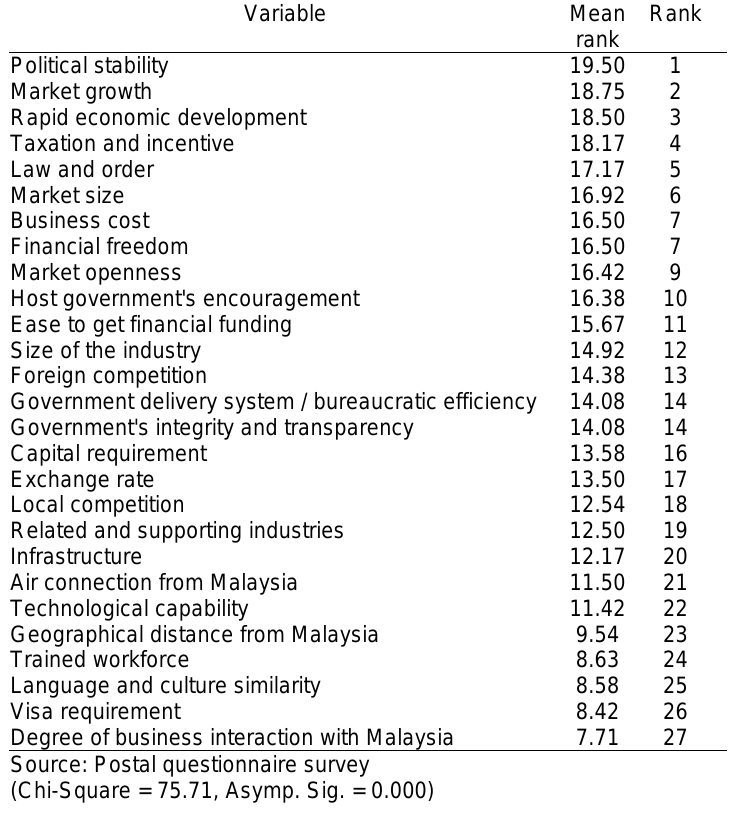
Table 3: Factors that Malaysian contractors considered when entering foreign